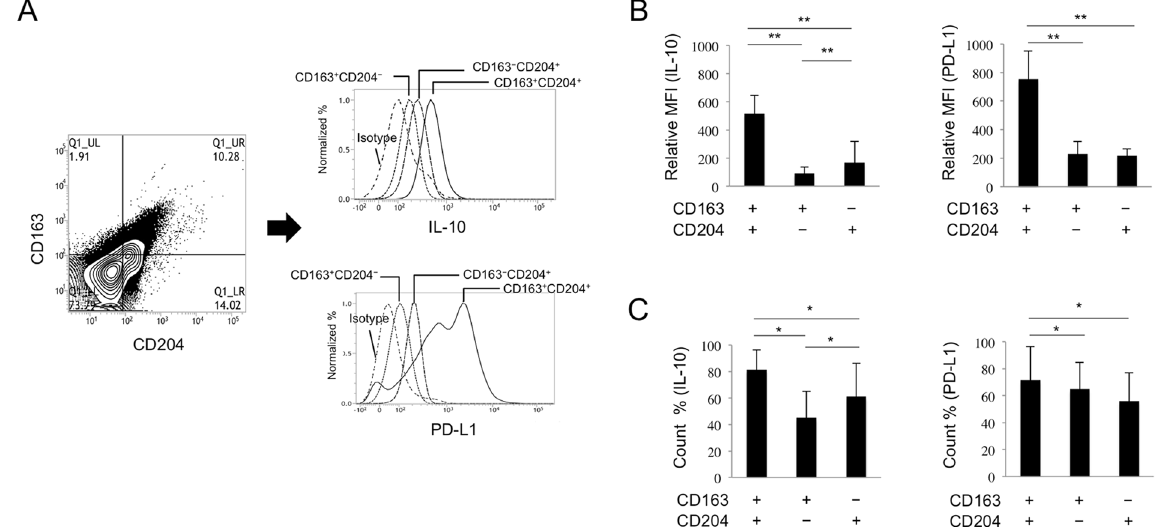
Figure 4. IL-10 and PD-L1 expression on TAM subsets in OSSC patients. ( A ) Flow cytometric analysis of IL-10 and PD-L1 expression on cultured TAM subsets. The detailed methods for cultivating cells are described in the Materials and Methods section. ( B ) IL-10 and PD-L1 expression (MFI; mean fluorescent intensity) on TAM subsets and ( C ) the number of IL-10 + and PD-L1 + cells were tested using flow cytometry (n = 3 for each subset). Statistically significant differences between groups were determined by Wilcoxon signed-rank test ( ** P < 0.01, * P <